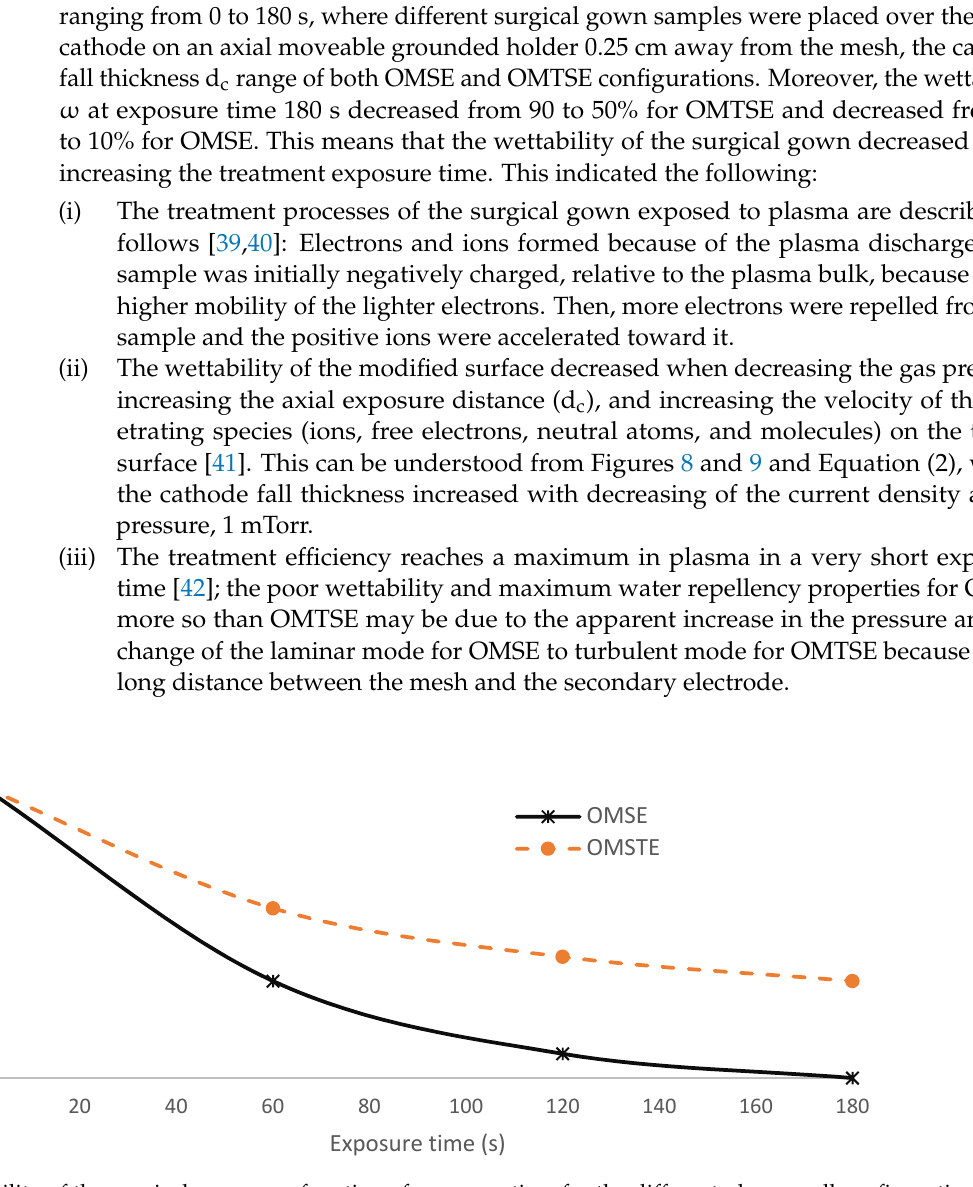
Figure 10. The wettability of the surgical gown as a function of exposure time for the different plasma cell configurations OMSE and OMTSE with applied pressure of 1 mTorr and cathode fall thickness of 0.25 cm.